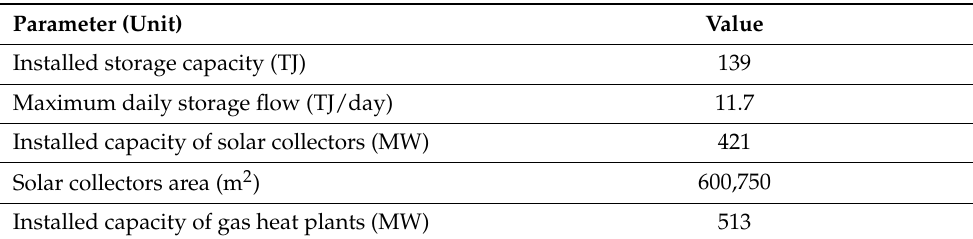
Table 10. The quantities characterizing the modeled system with the required share of heat from solar collectors =